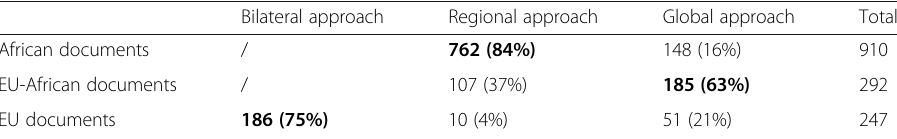
Table 3 Use of ‘ trafficking or smuggling ’ across approaches (main approach in bold) Bilateral approach Regional approach Global approach Total African